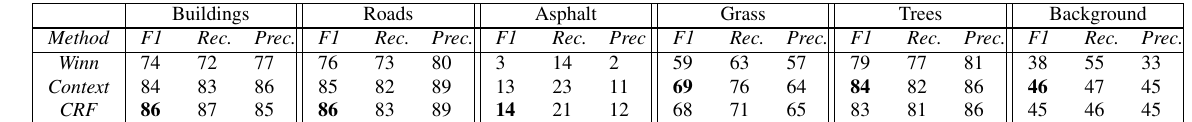
Figure 4. Multi-class semantic segmentation results for the two tiles shown in Fig. 3: ground truths (left column), predictions from the unary classifier of Sec. 3.1 (center column), and final results after CRF inference with class-specific priors for buildings and roads (right column).